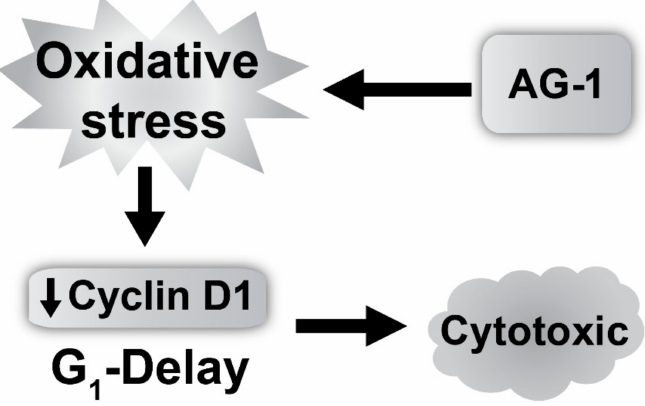
Figure 11. An illustration of AG-1 inducing oxidative stress and G 1 delay resulting in